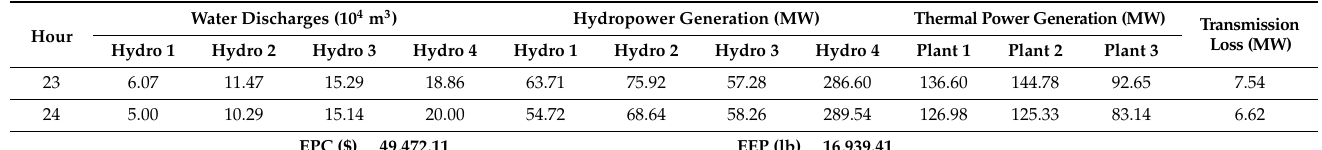
Table 8. EEP minimization schedule results of DOGSA for Test system-II.